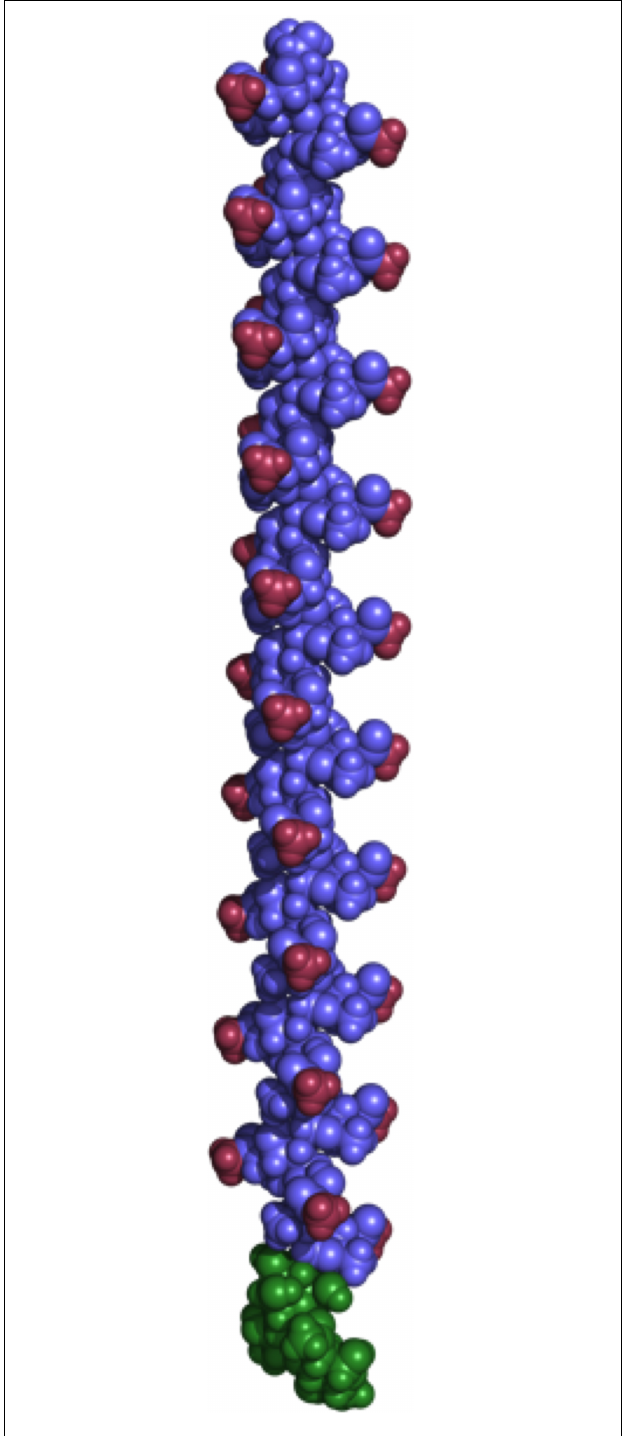
FIGURE 8 | Novel epitopes are accessible for antibodies in the O-PS of Ba:: Tn7wbdR (cid:49) wbkC . The polysaccharide structure containing 30 residues of → 2)- α - D -Rha p 4NAc-(1 → connected to two adaptor sugars and a primer → 4)- α - D -Man p -(1 → 3)- α - D -Man p -(1 → 3)- β - D -Qui p NAc which links to the core, was generated by CarbBuilder v2.1.17 and visualized with PyMol 1.3. Methyl groups of N -acetyl groups in perosamine residues are highlighted in red